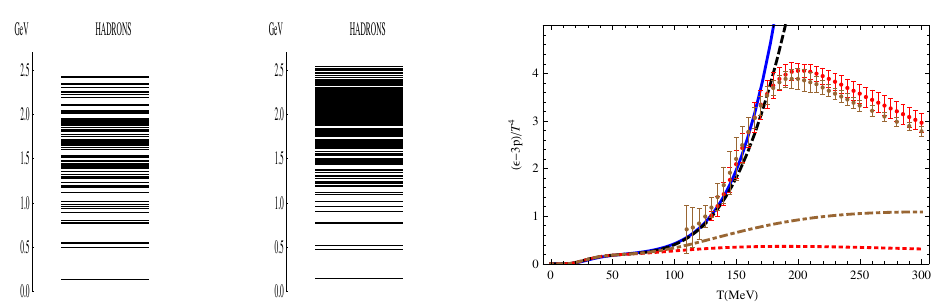
Figure 1. Left panel: The PDG hadron spectrum [8] Middle panel: The RQM hadron spectrum [9, 10]. Right panel: Trace Anomaly in lattice QCD [13, 14] vs HRG using PDG (dashed) and RQM (solid) spectra. We also plot just the contribution of states with M < 0 . 6GeV (dotted) and M < 0 .